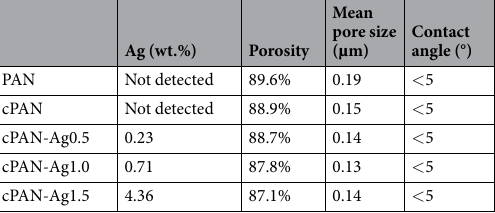
Table 1. Physical and chemical properties of the nanofibrous membranes.